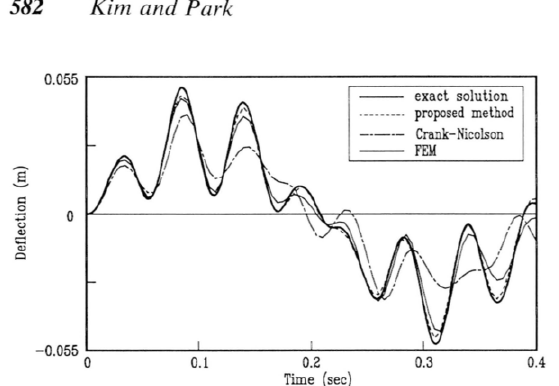
FIGURE 8 Comparison of the exact and numerical solutions.